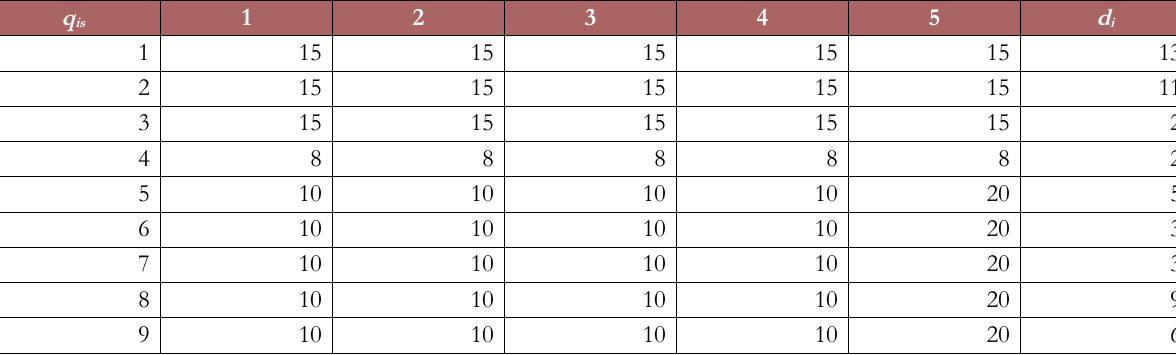
Table 4. The capacity of the factory to manufacture each part and the demand in each